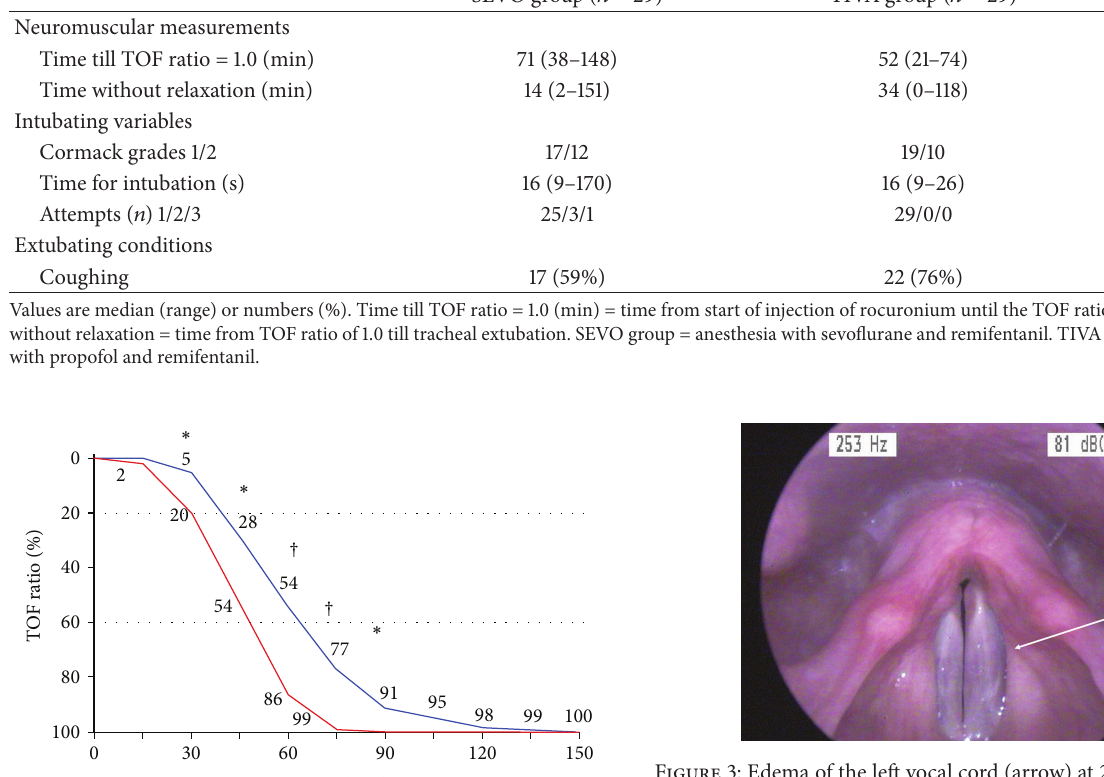
Table 3: Neuromuscular measurements, intubating variables, and coughing during removal of the tracheal tube. SEVO group ( 𝑛 = 29 ) TIVA group ( 𝑛 = 29 )